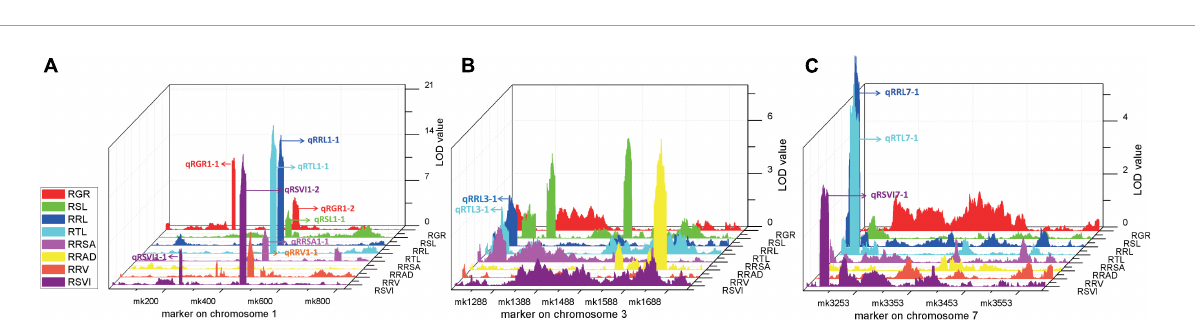
FIGURE3 QTL map of consistent segments related to multiple low-temperature tolerance traits in the RIL population during germination. (A) QTL of eight phenotypes on chromosome 1, (B) QTL of eight phenotypes on chromosome 3, (C) QTL of eight phenotypes on chromosome 7. For each trait, different colors represent the eight different traits related to low-temperature tolerance (RGR, RSL, RRL, RTL, RRSA, RRAD, RRV, and RSVI).